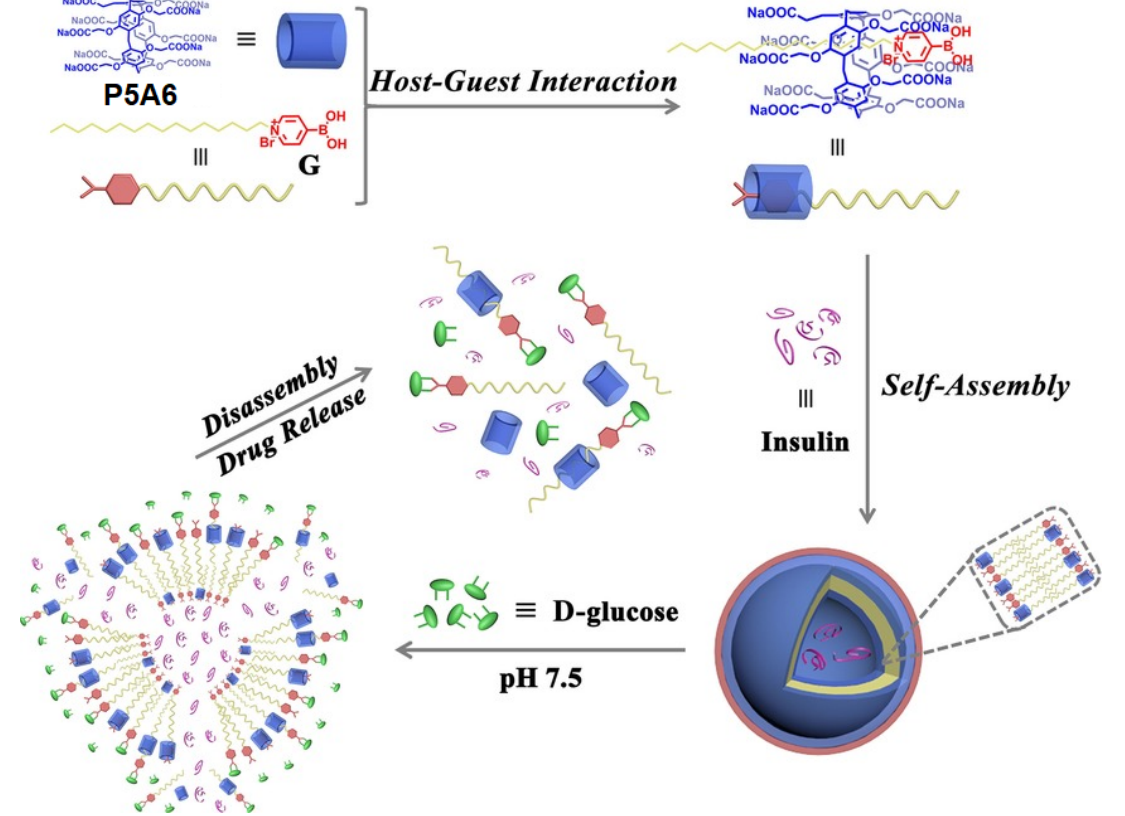
Figure 21. Schematic illustration of the formation of supramolecular vesicles based on “ P5A6*G ” supra-amphiphile and their glucose-responsive insulin release. Reproduced from reference [104].